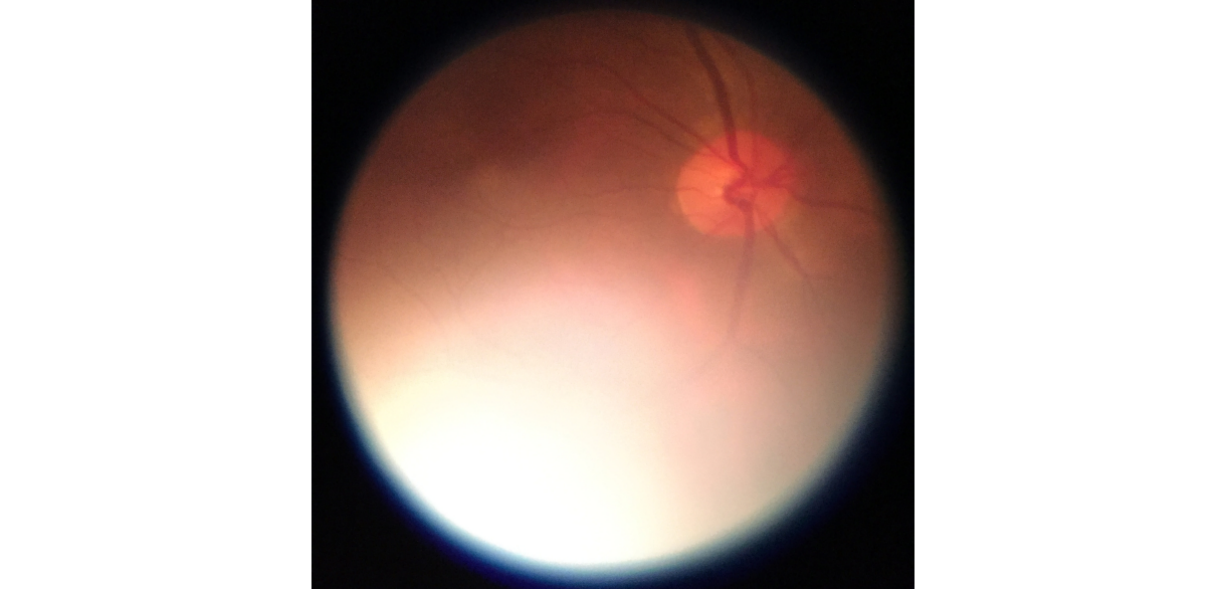
Figure 8. Smartphone-based fundus image of the posterior pole acquired without pupil dilation. Compared to imaging with pupil dilation, field of view is constrained due to increased glare from the image